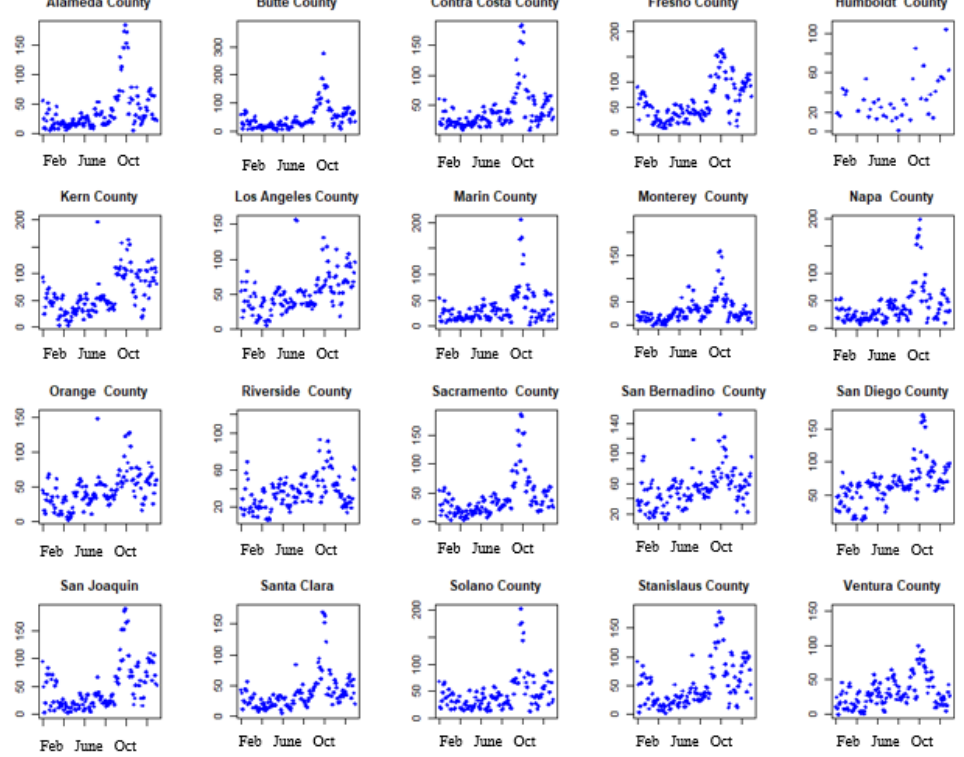
Figure 3. Time series of air quality (AQI) in the 20 counties during the study period.